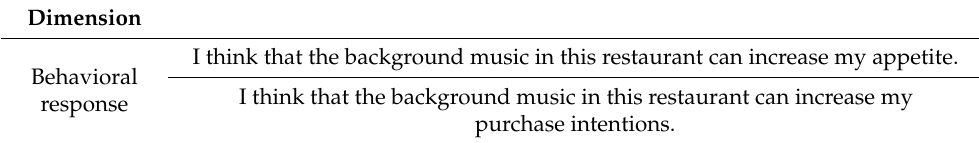
Table 3. Behavioral response